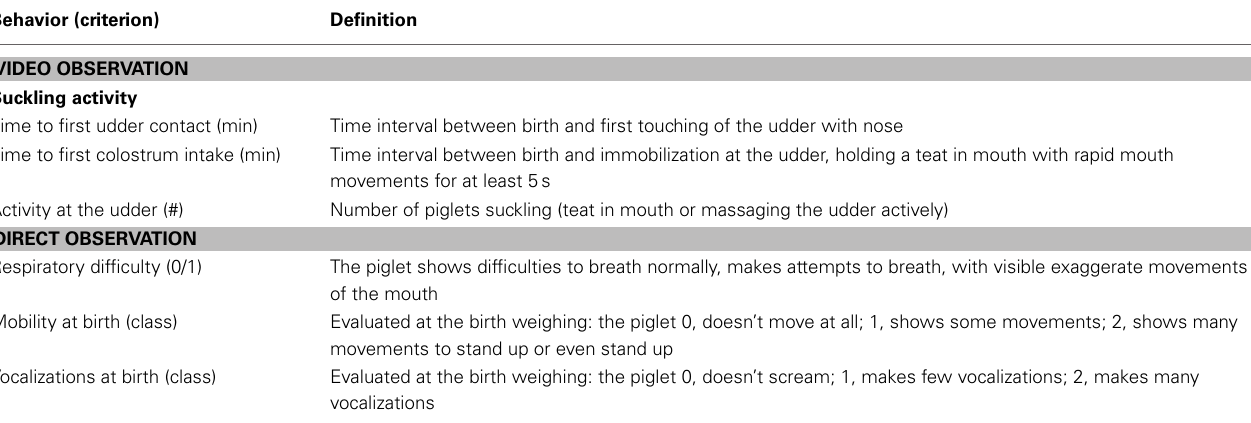
Table 2 | Behavioral measurements for the comparison of old-type and modern-type newborn